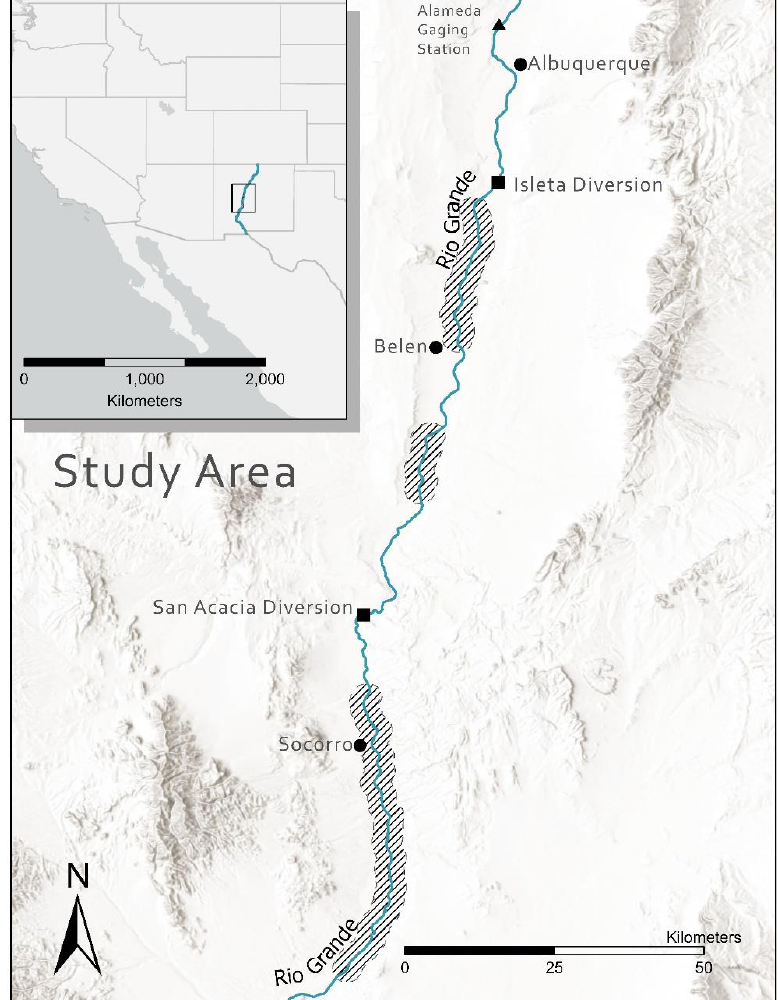
Figure 1. Areas of streamflow intermittency (crosshatched areas) in the Middle Rio Grande Basin of New Mexico, where temperatures of isolated pools were collected from 2011 to 2016. Circles represent metropolitan areas, squares are surface flow diversion structures, and the triangle is a streamflow and water quality gauging station.